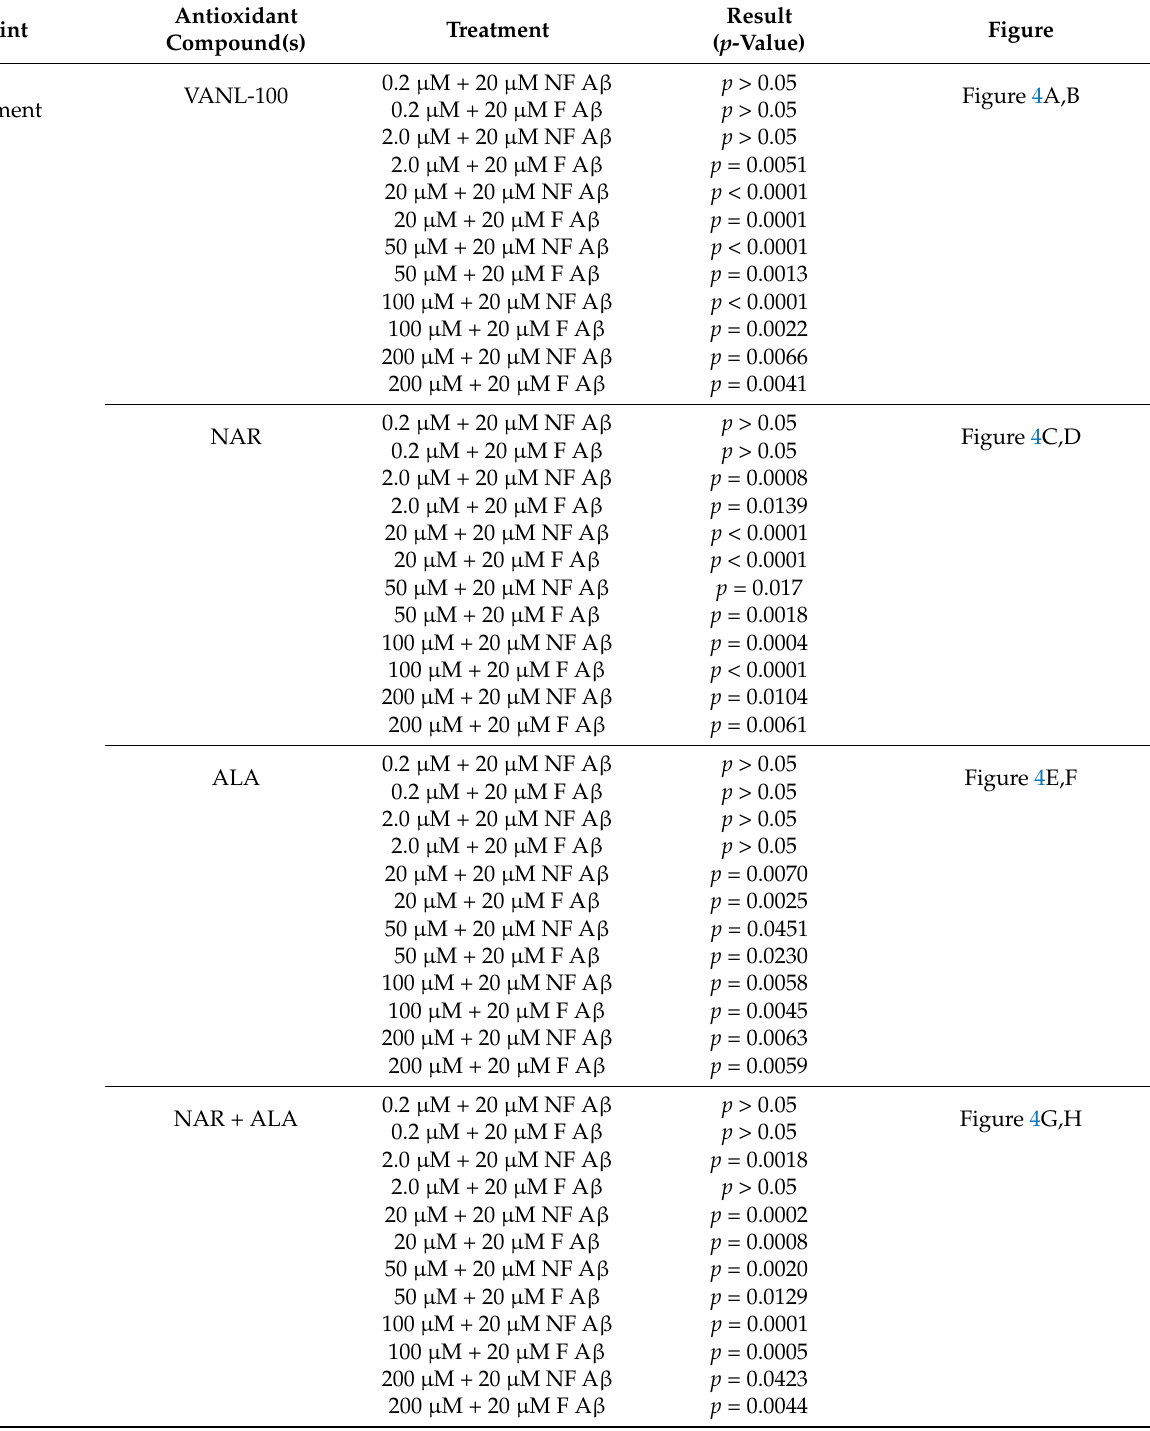
Table 1. Summary of results. NAR: Naringenin; ALA: Alpha-lipoic acid; NAR + ALA; Naringenin + Alpha-lipoic acid; NF: Non-fibril; F: